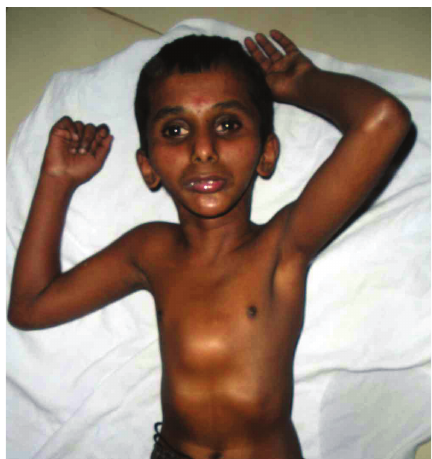
Figure 6: It shows the patient being unable to stand and is lying down, and chest showed pectus carinatum structure.